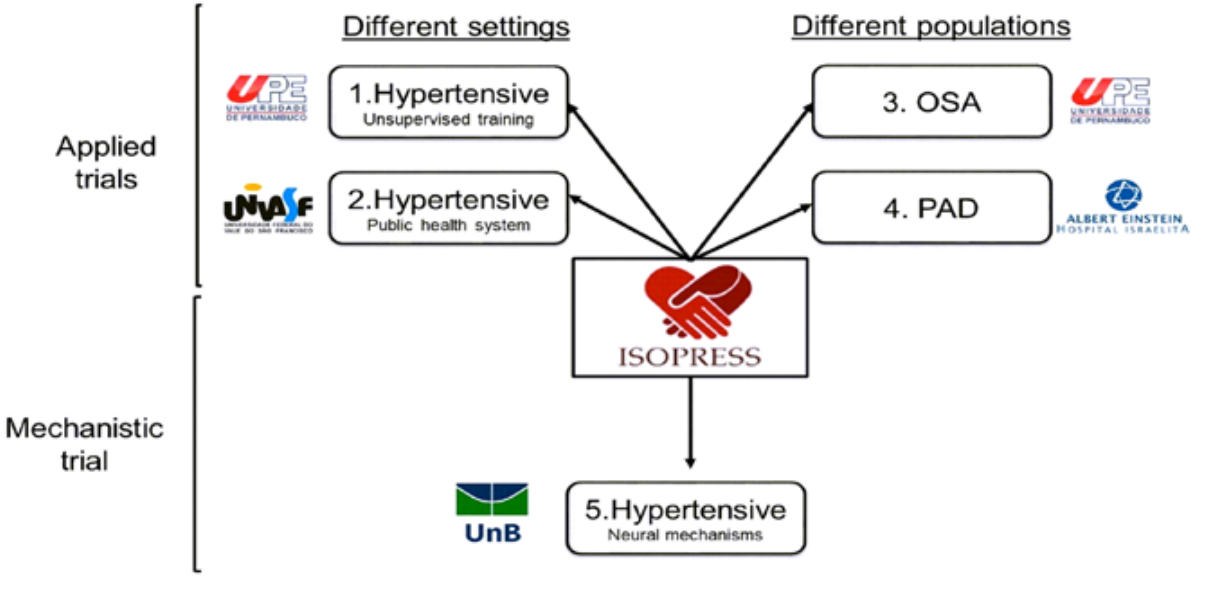
Figure 1. Rationale of ISOPRESS network. OSA - Obstructive Sleep Apnea. PAD – Peripheral artery disease.